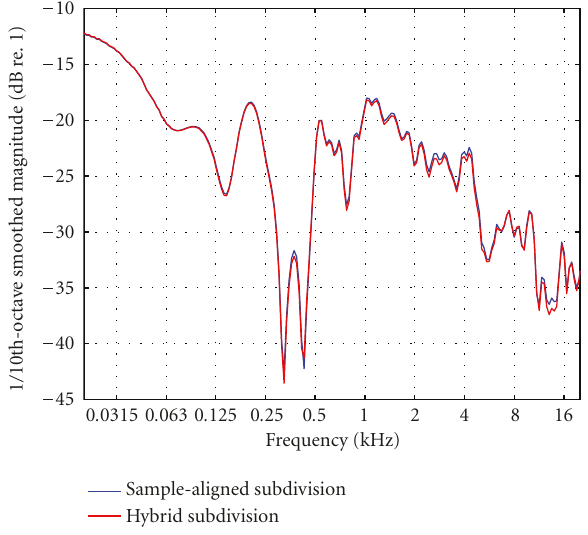
Figure 8: 1/10th-octave smoothed magnitude spectra for the im- pulse responses in Figure 7. See Figure 9 for the di ff erence between the